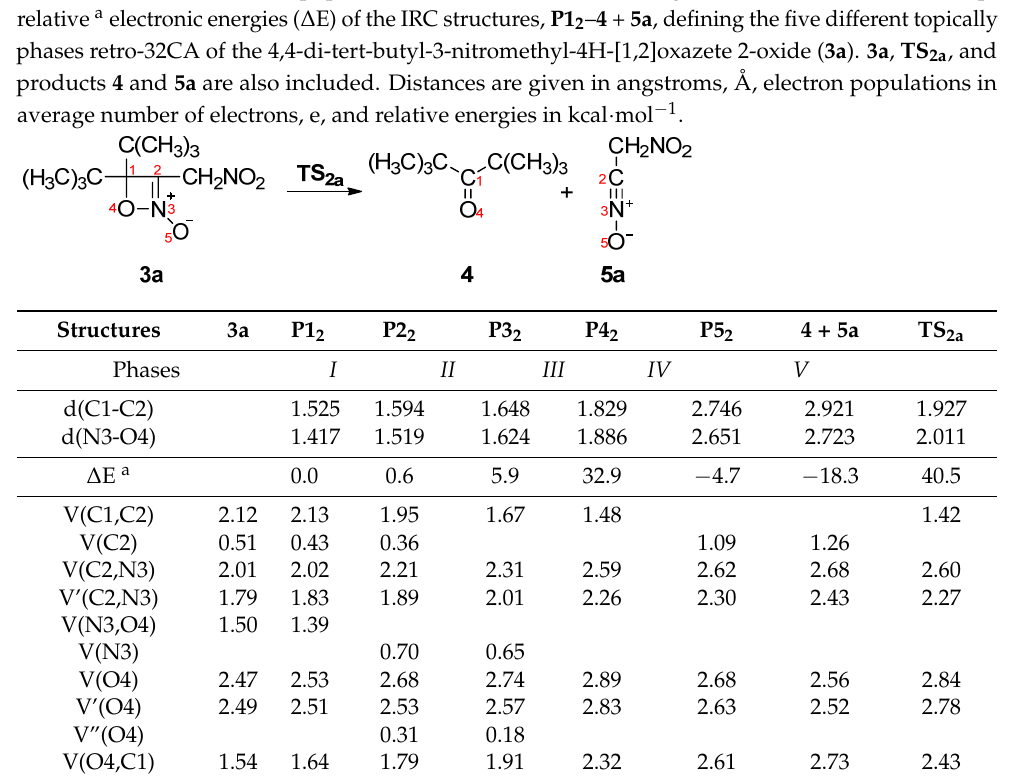
Figure 5. Attractor positions of the most important ELF valence basins of the IRC structures P1 2– 4 + 5a together with simplified representation of the molecular mechanism by Lewis-like structures arising from the topological analysis of the ELF along the reaction path for the retro-32CA of the 4,4-